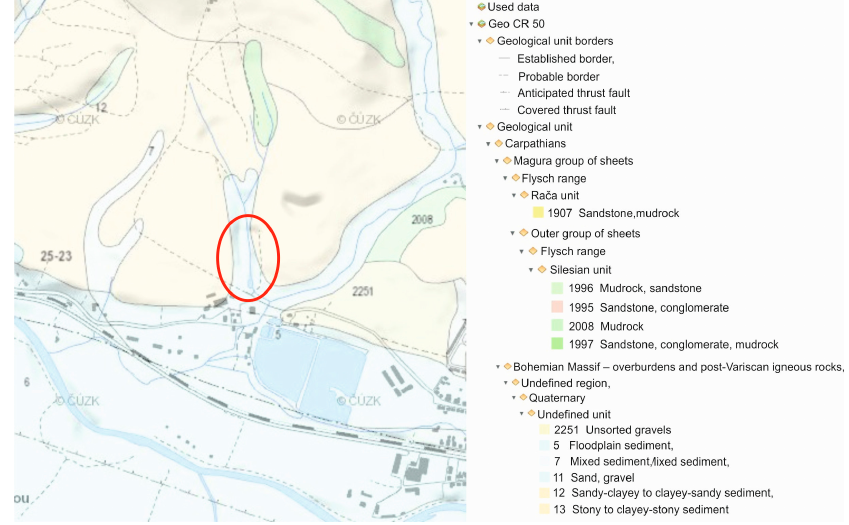
Figure 2. Geological situation of the wider surrounding area on a geological map of CR cut out (1:50,000) with an indicated area of interest. (1:50,000) with an indicated area of